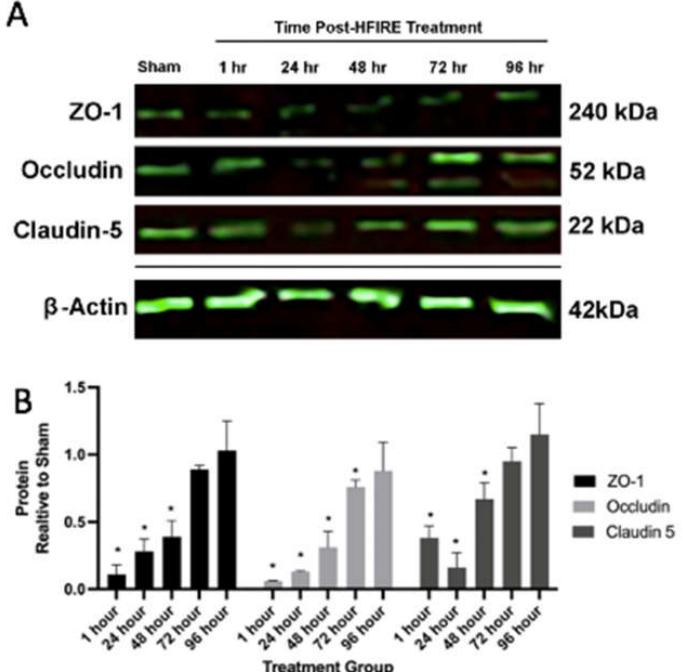
Figure 2. Western blot ( A ) and corresponding protein quantification normalized to β-actin (loading control) ( B ) demonstrating transiently decreased expression of TJPs, zonula occudens-1 (ZO-1), occludin and claudin-5, following H-FIRE treatment relative to sham controls. * indicates statistically significant differences in protein concentrations compared to sham controls ( p < 0.05).